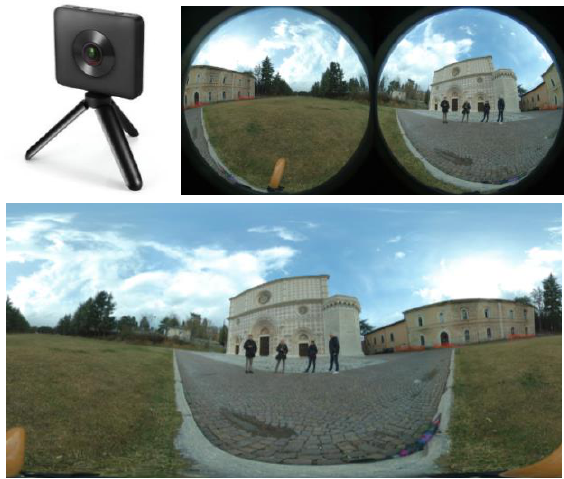
Figure. 1 The Xiaomi Mijia Mi Sphere 360 used in this work.